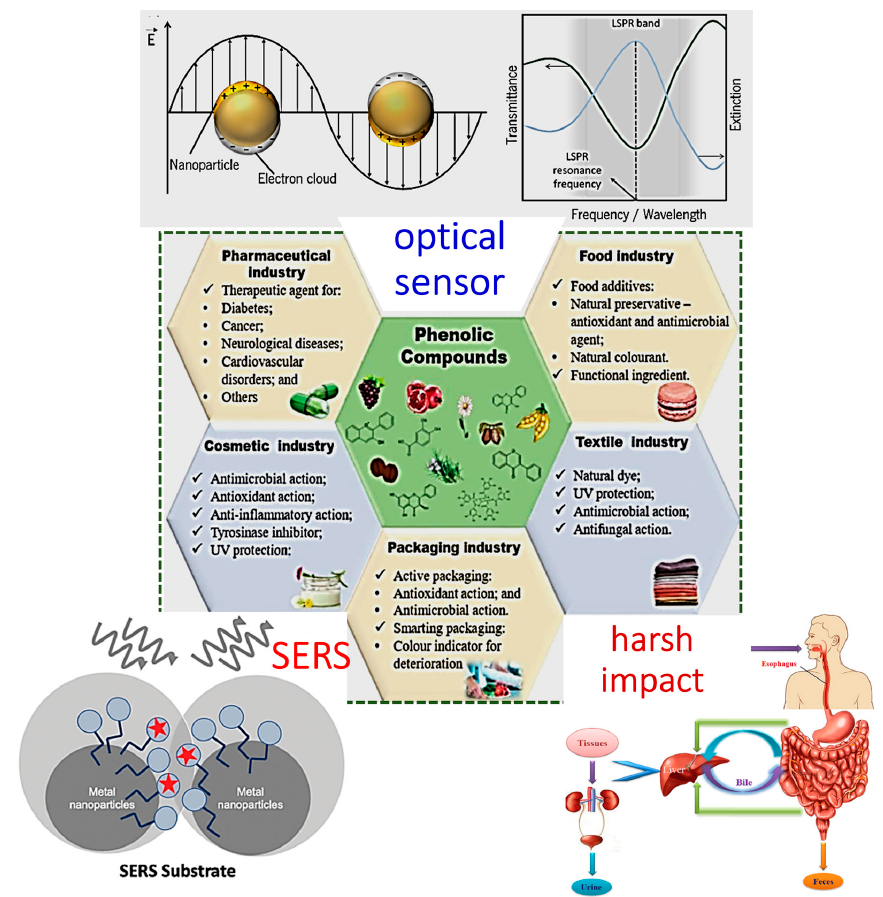
Figure 1. Applications of plasmonic resonance-based optical sensor for on-site detection of phenolic compounds that impact the human health risk. Adapted from [2,31,43,44] with permission.